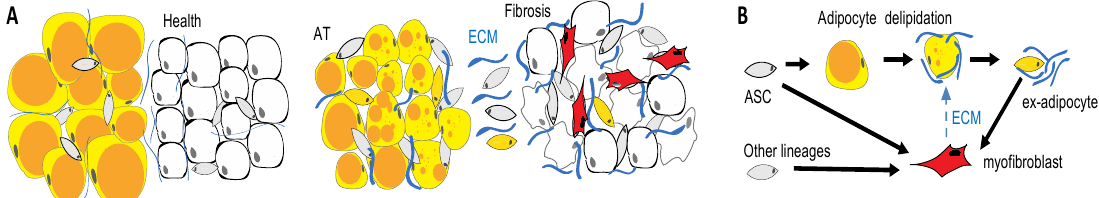
Figure 4. WAT cells as drivers of fibrosis. ( A ) Tissue remodeling in fibrosis. Pathogenic changes in the epithelium (white) induce the activation and proliferation of fibroblasts in adjacent adipose tissue (AT). ( B ) AT fibrosis is linked with loss of lipid droplets (orange) in adipocytes, which may convert into myofibroblasts that promote disease. Activated myofibroblasts (red) deposit an extracellular matrix (ECM). Adipose tissue is a key source of cells that convert into myofibroblasts secreting extracellular matrixes (ECMs) and driving